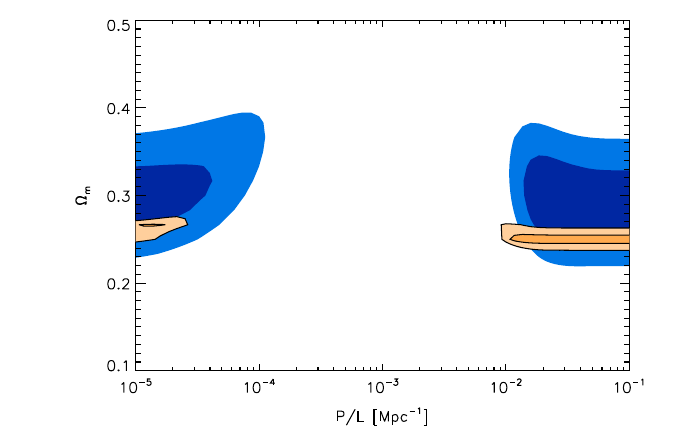
Fig. 56 Constraints on the simplest Axion-like particles models. Blue regions represent current constraints while orange are forecast Euclid constraints assuming it is accompanied by a Dark Energy Task Force stage IV supernovae sample. Here P / L is the conversion probability per unit length and is the relevant parameter for τ( z ) . Image reproduced with permission from Avgoustidis et al. (2010), copyright by IOP